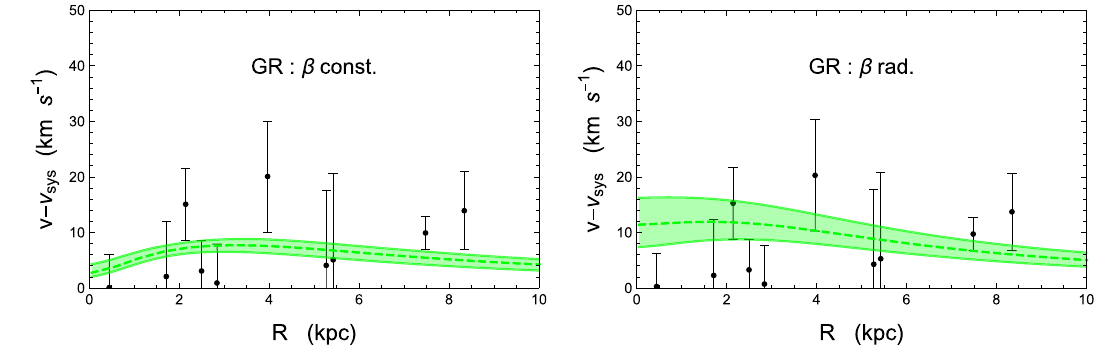
Fig. 1 Velocity offset profiles of NGC1052-DF2 with GR and no DM component, but only the stellar contribution. Black dots and bars are observational data, v i − v sys , with uncertainties, σ v